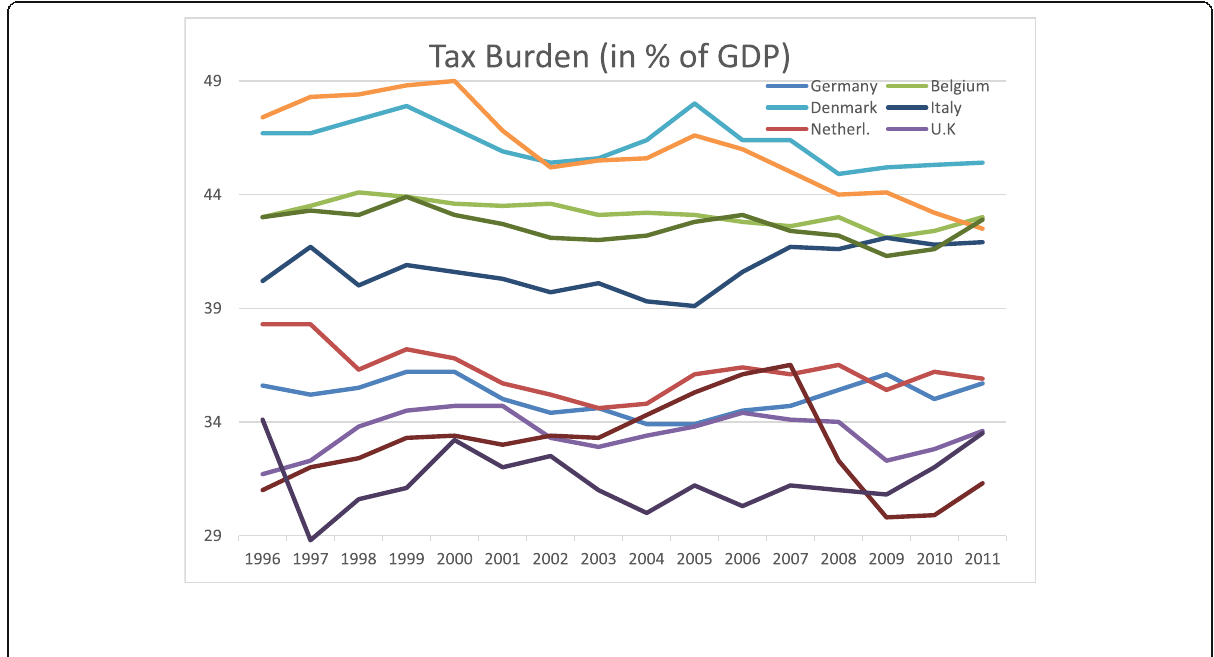
Fig. 3 Tax burden in selected EU countries, 1996 – 2011 (in % of GDP). Source: Own elaboration based on data from [29], p. 84 –